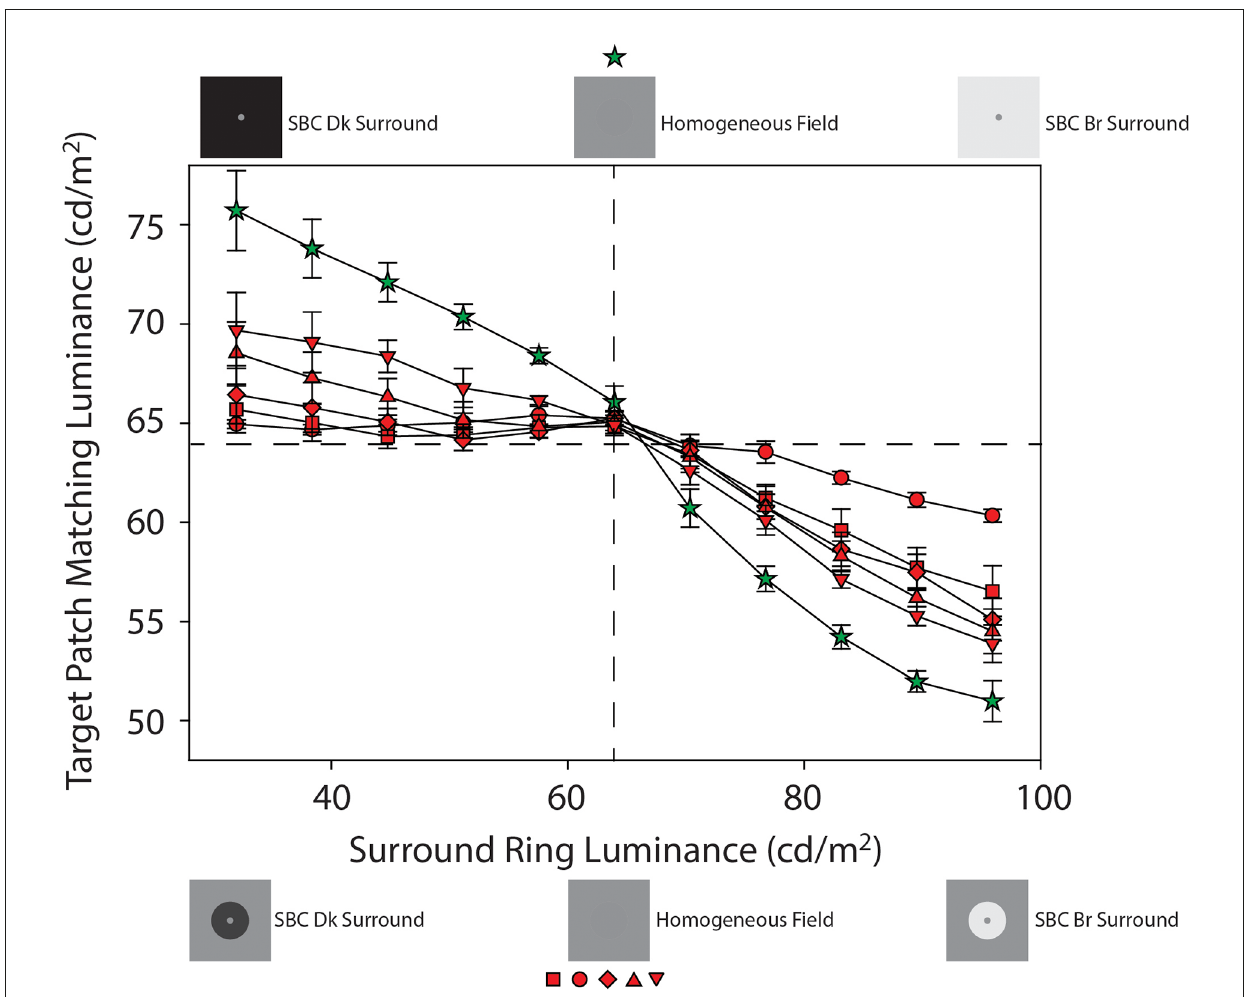
FIGURE4 Mean target patch matching luminance from Experiment 1 plotted as a function of adjacent surround-ring luminance on the 64 cd/m 2 remote background (red symbols) and on the full-field adjacent surround (green stars). These data from Figure 3 are plotted on an expanded target patch matching luminance axis for clarity. The red symbol shapes represent the various adjacent surround-ring widths (0.1 ◦ = circles, 0.3 ◦ = squares, 0.5 ◦ = diamonds, 1.0 ◦ = triangles, 2.5 ◦ = inverted triangles). Adjacent surround-ring luminance in each condition ranged from 32 cd/m 2 to 96 cd/m 2 . The stimulus icons at the top of the figure depict examples of the stimuli in the extended (full field) surround-ring matching condition represented by the green stars. The stimulus icons at the bottom of figure depict examples of the stimuli for the smaller adjacent surround-ring widths (red symbols) on the 64 cd/m 2 remote background (see text for